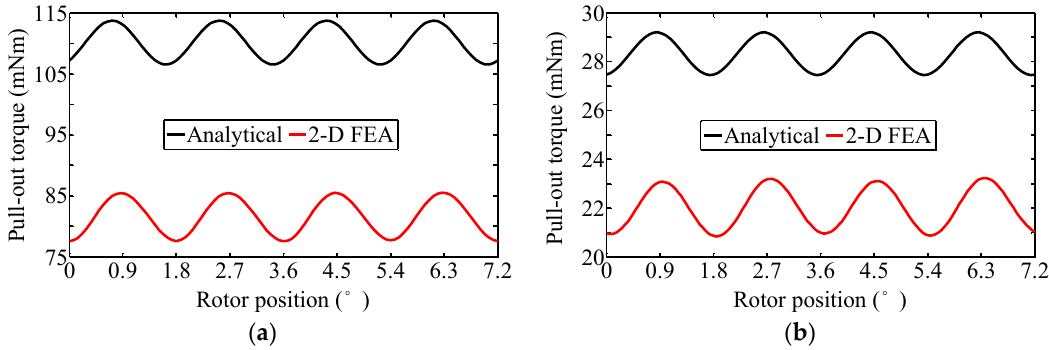
Figure 21. Comparison of maximum pull-out torque by analytical method and 2-D FEA with rated sinusoidal current excitation. ( a ) Sub-motor1; ( b ) Sub-motor2.